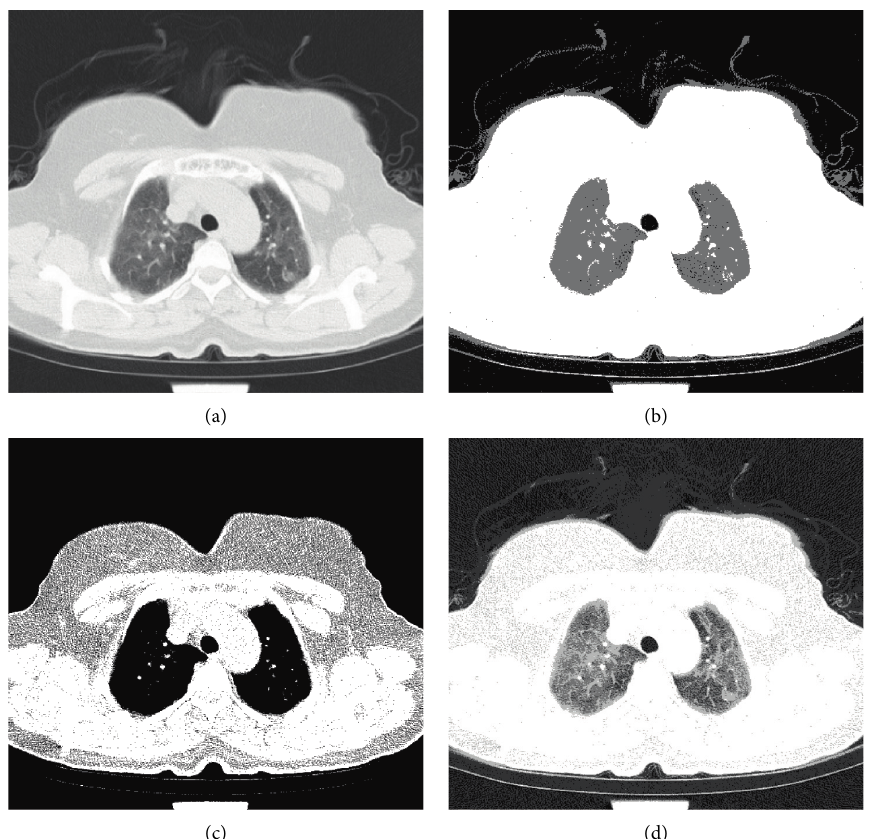
Figure 7: CT image-6 segmentation results of three threshold levels using the proposed approach. (a) Original CT image, (b) level-2 threshold Segmentation, (c) level-3 threshold segmentation, and (d) level-4 threshold